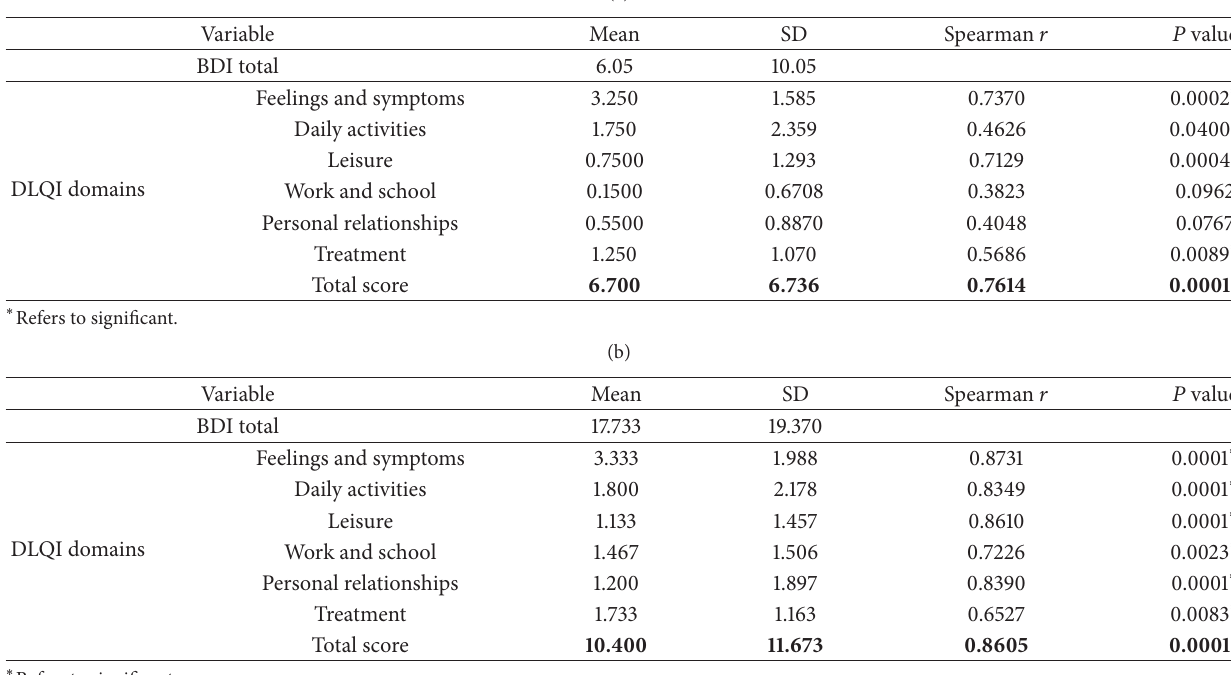
Table 4: (a) Association of BDI with DLQI in males. (b) Association of BDI with DLQI in